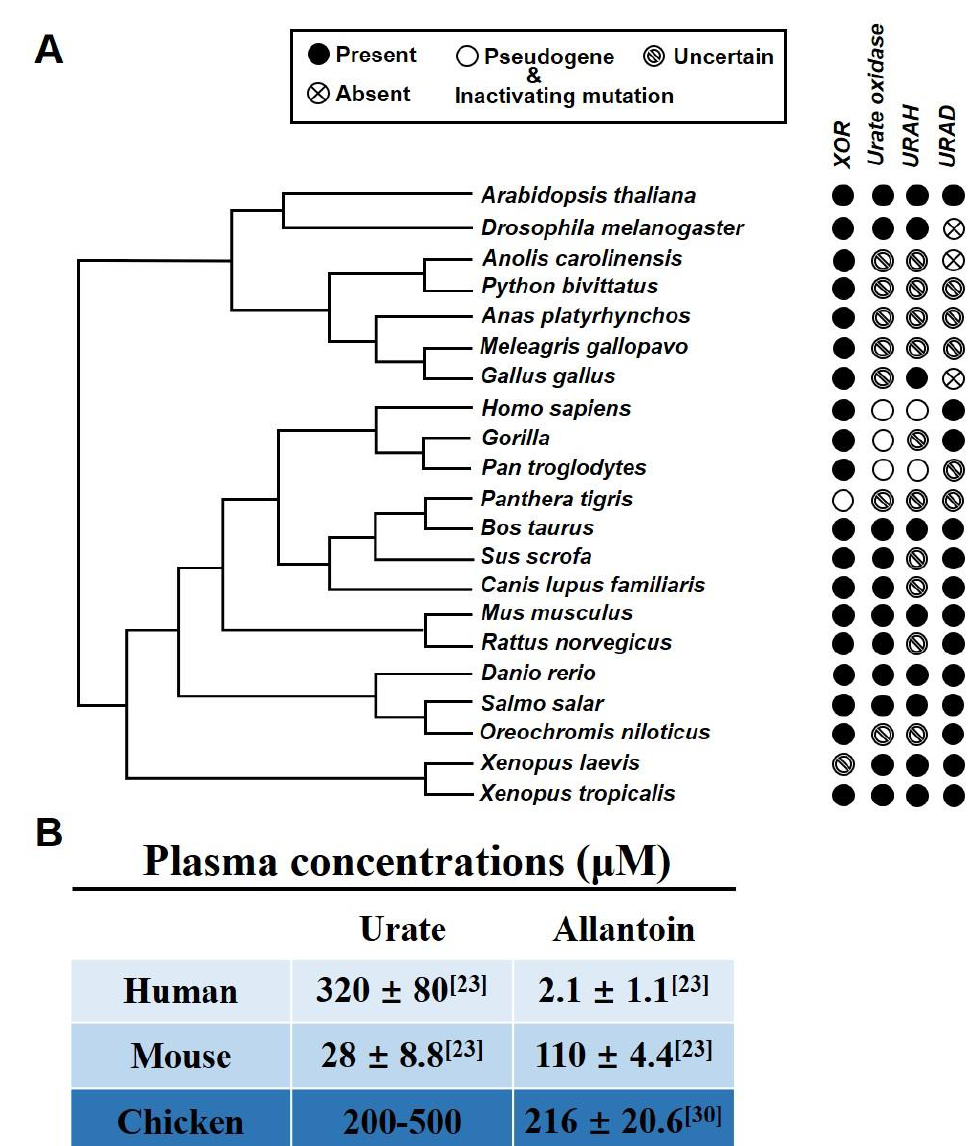
Figure 2. Chicken as a suitable hyperuricemia model among various organisms. ( A ) Phylogenetic tree of urate metabolism-related genes. All participate sequence alignment information was based on database in NCBI gene, the uncertain sign is represented for no related information could obtain in this database. ( B ) Plasma concentrations of urate and allantoin in humans, mice, and chickens. The urate and allantoin level in plasma of human and mouse is referenced from Cantor J et al. [23]; and the level of allantoin is referenced from Carro M.D. et al. [30]; the range value of plasma urate in chicken is from our studies.